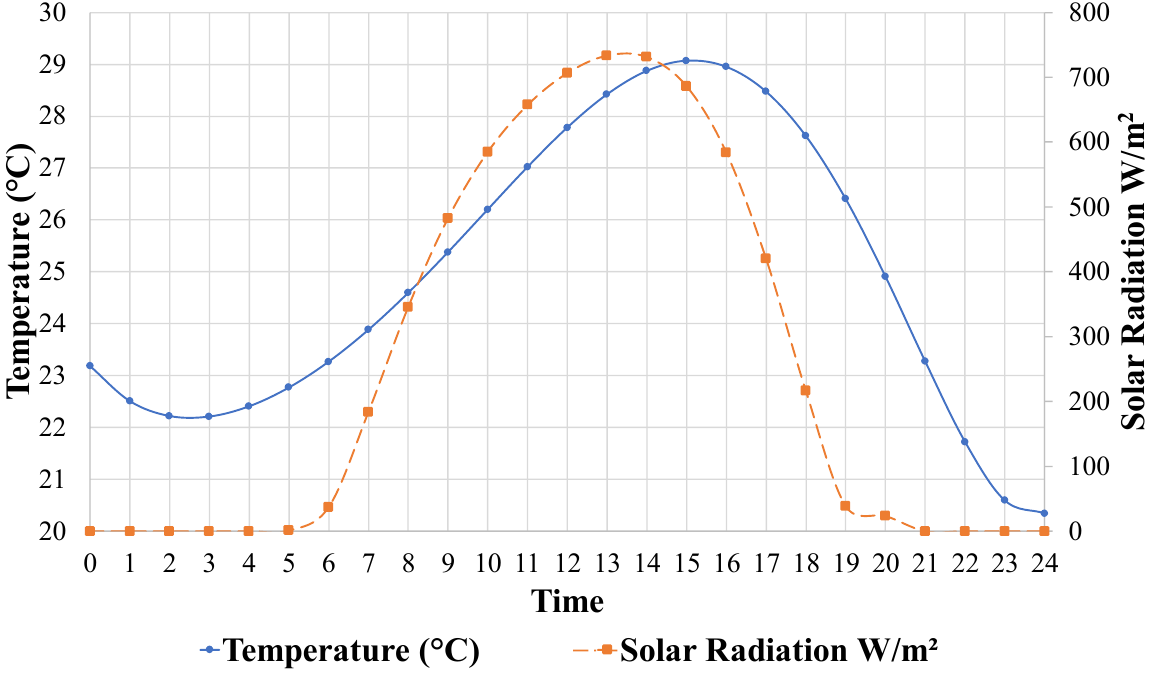
Figure 9. Temperature and solar radiance data for data collection day of Apple Rd bridge (30th of July 2021) Newark, Delaware [67].